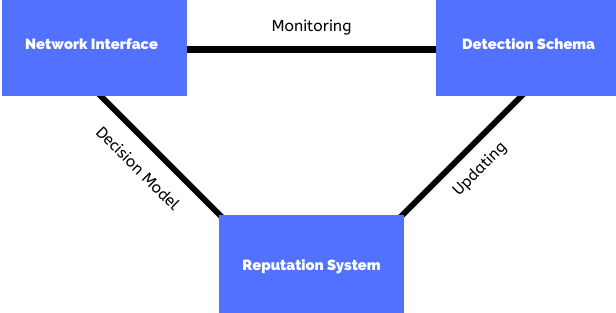
Figure 4. The selfishness assessment system running at each network